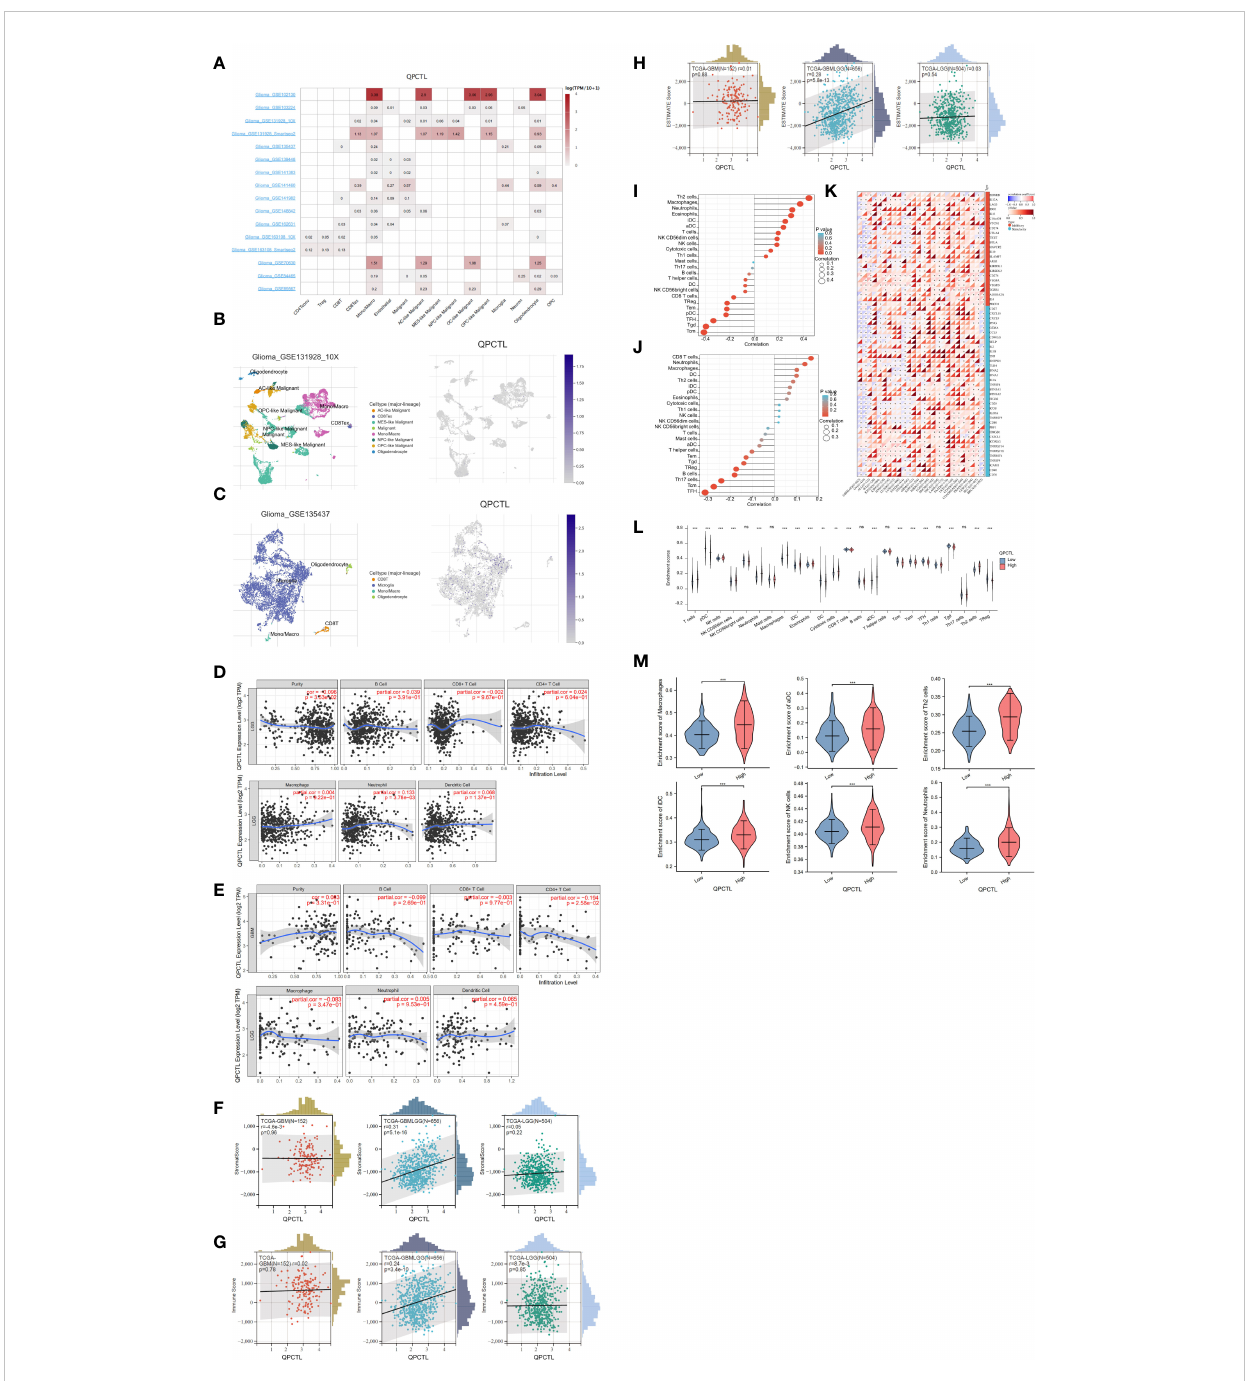
FIGURE 5 Correlation analysis between QPCTL expression and in fi ltrating immune cells (A) The expression of QPCTL in different immune cells, data from GEO data single-cell sequencing. (B) QPCTL expression in the glioma single-cell sequencing data (GSE131928). (C) QPCTL expression in the glioma single-cell sequencing data (GSE135437). (D) Correlation of QPCTL expression with in fi ltrating immune in fi ltration in LGG from TIMER database. (E) Correlation of QPCTL expression with in fi ltrating immune in fi ltration in GBM from the TIMER database. (F) Relation between QPCTL expression and stromal score in GBM, GBMLGG, and LGG. (G) Correlation of QPCTL expression with in fi ltrating immune score in GBM, GBMLGG, and LGG from the TCGA database. (H) Correlation of QPCTL expression with ESTIMATE score in GBM, GBMLGG, and LGG from the TCGA database. (I) The immune cell in fi ltration in the QPCTL-high and -low groups. (J) The immune cells with higher in fi ltration in QPCTL-high groups. (K) The correlation between the expression of QPCTL and the immune checkpoints. (L) The enrichment scores of immune cells in QPCTL-high and -low group. (M) The enrichment score of macrophage, iDC (immature DC cell), aDC (activated DC cell), Th2 cell, and Neutrophils in the QPCTL-high and -low groups. Data from http://sangerbox.com/, TCGA TARGET GTEx (PANCAN, N = 19,131, G = 60,499). ** p < 0.01, *** p <